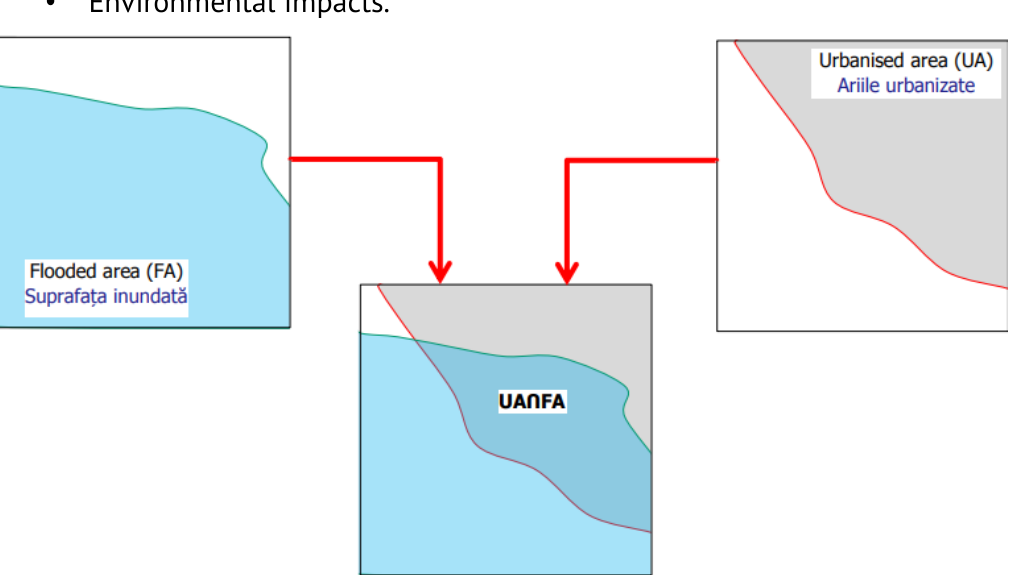
Figure 8. Graphical interpretation of the vulnerability